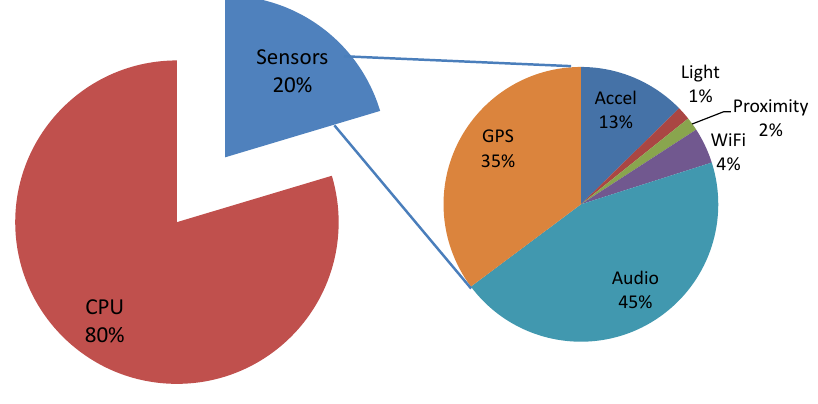
Figure 12. myBlackBox application’s battery usage for one 30-min